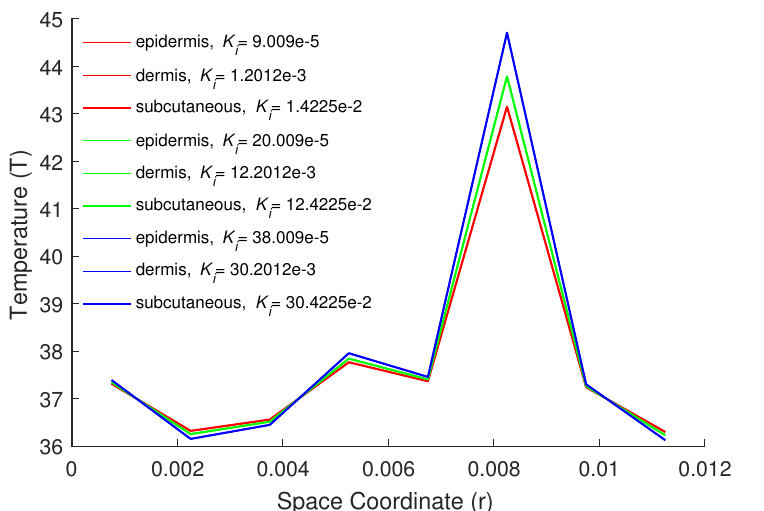
Figure 10. Temperature distributions for different values of K i in second kind B.C.